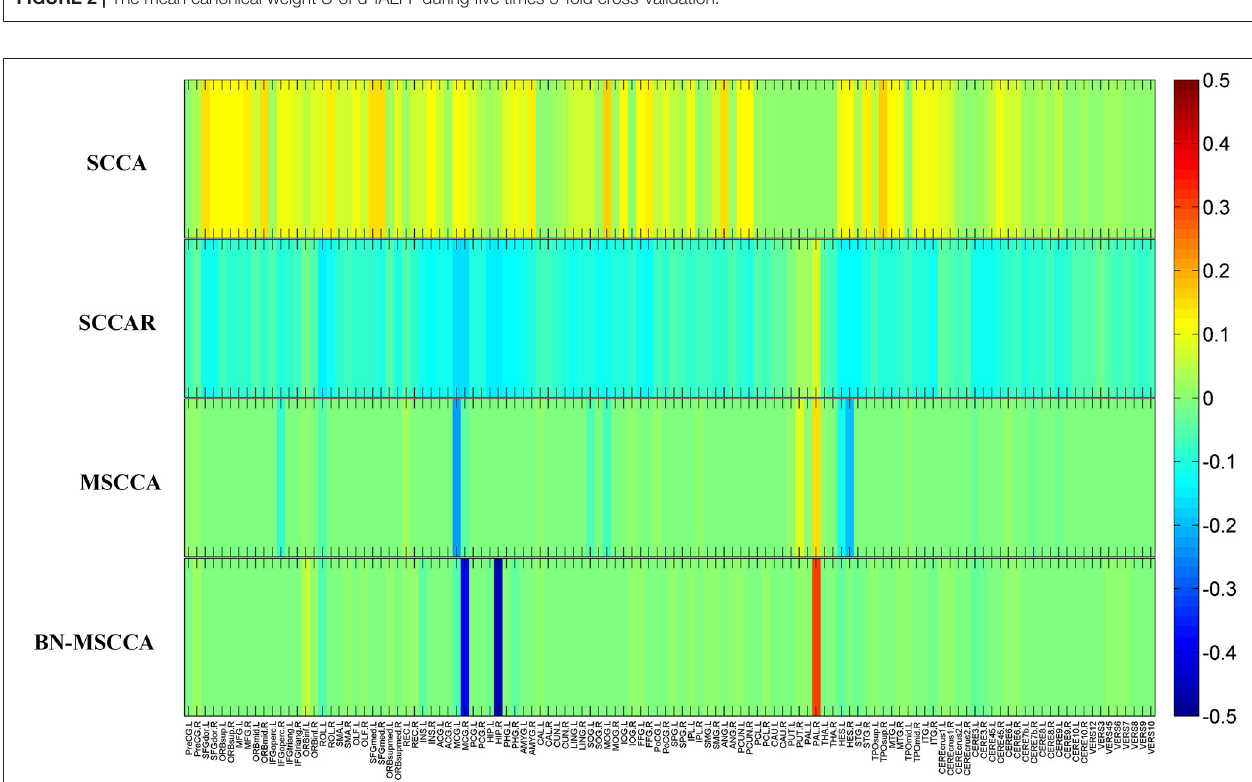
FIGURE 3 | The mean canonical weight V of gray matter volume during five times 5-fold cross-validation.